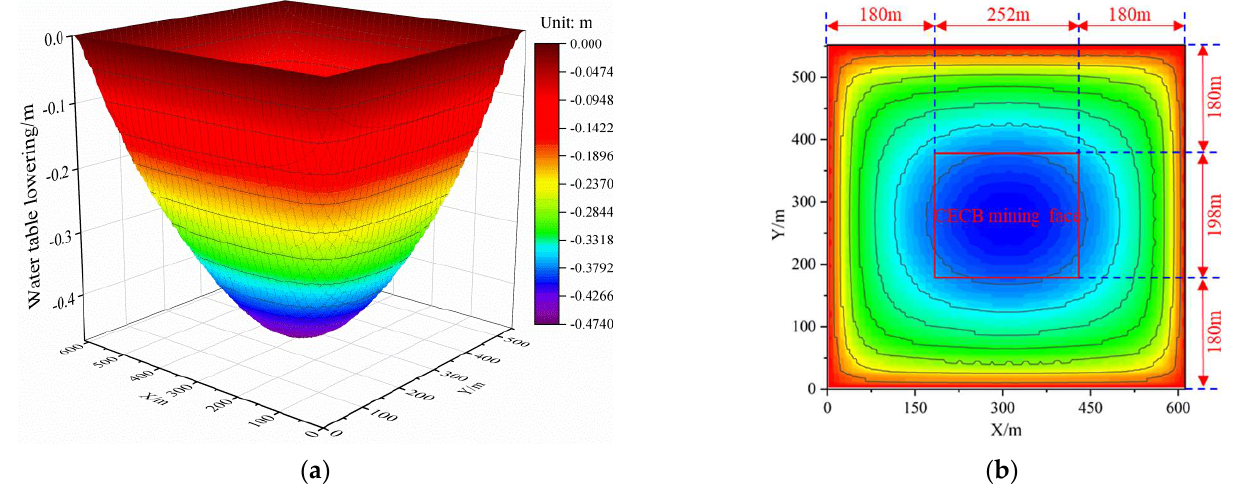
Figure 15. The numerical simulation results of shallow water level drop of the colliery when injecting the CMFB with 75% fly ash into the mined-out area. ( a ) The groundwater depression cone; ( b ) the contour map of water table lowering.